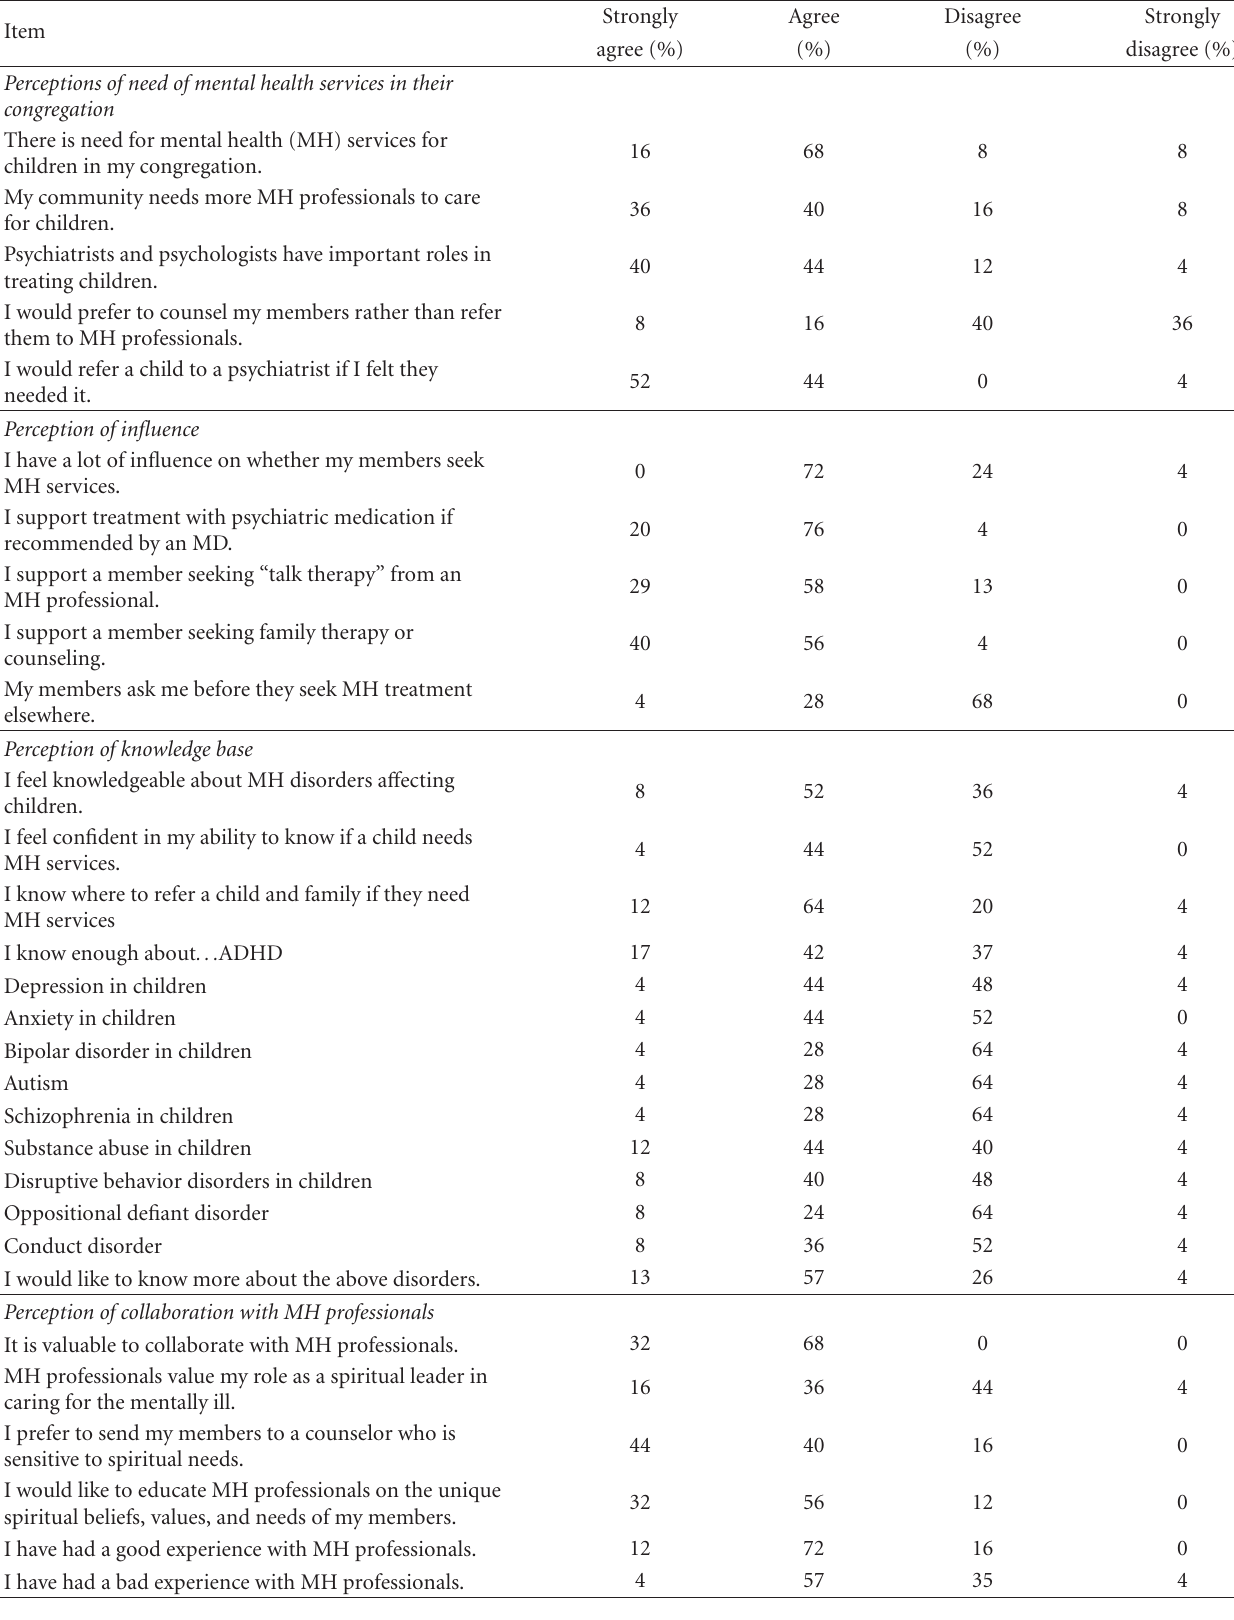
Table 1: Survey items and responses ( N =